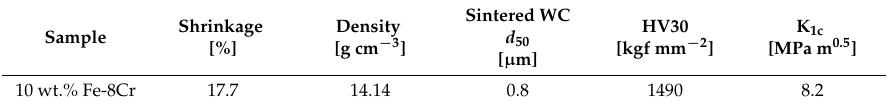
Table 1. Physical properties of as-sintered cWC material.